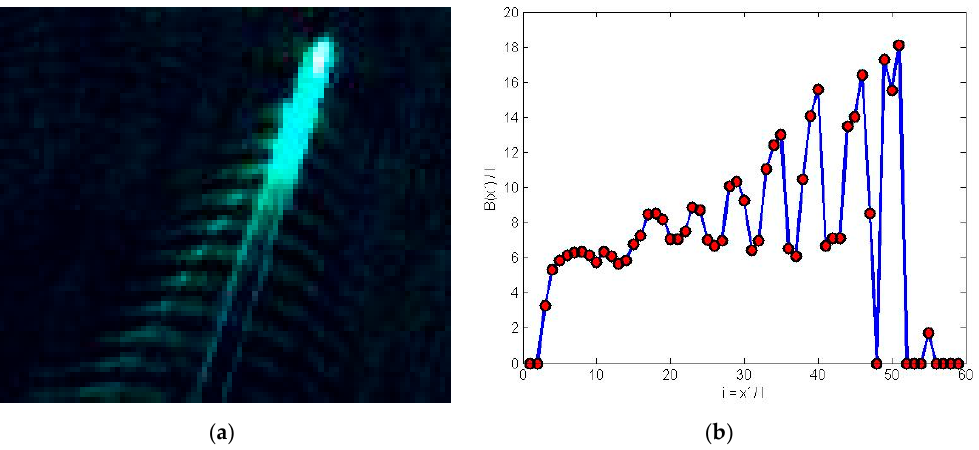
Figure 5. ( a ) Ship with Kelvin waves and turbulent wake; ( b ) Corresponding ship breadth B(x’) along ship axis x’ including wake oscillations.